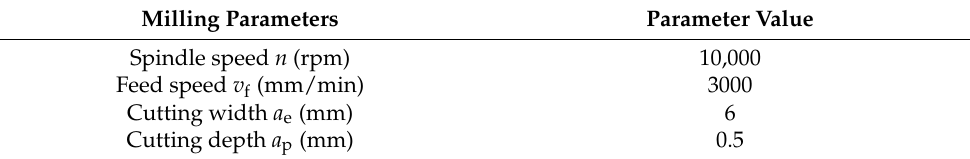
Table 3. Experimental